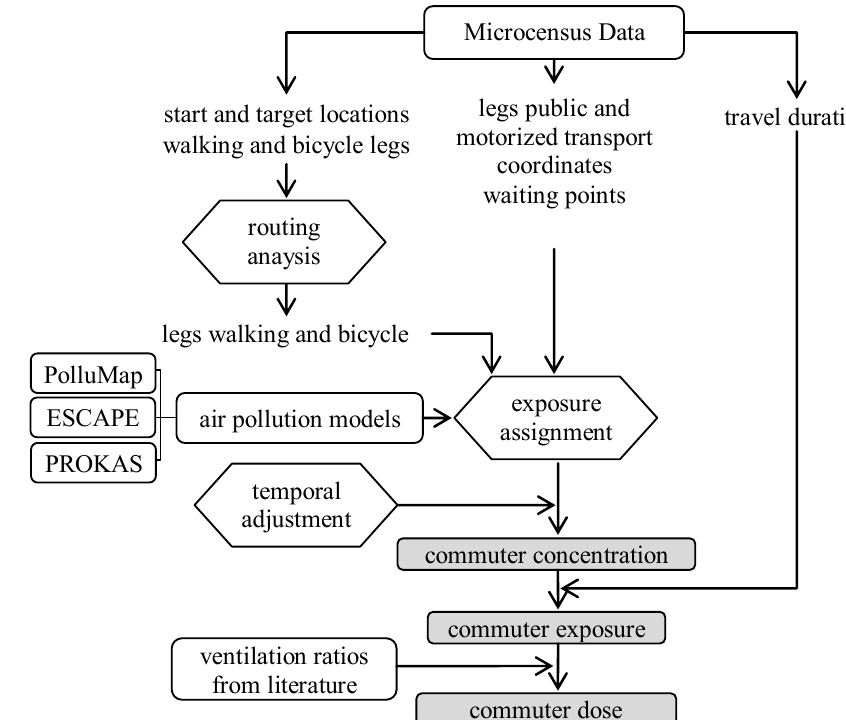
Figure 2. Schematic representation of the applied methodology. Boxes are inputs, and hexagons are analysis steps. Shadowed boxes indicate commuter